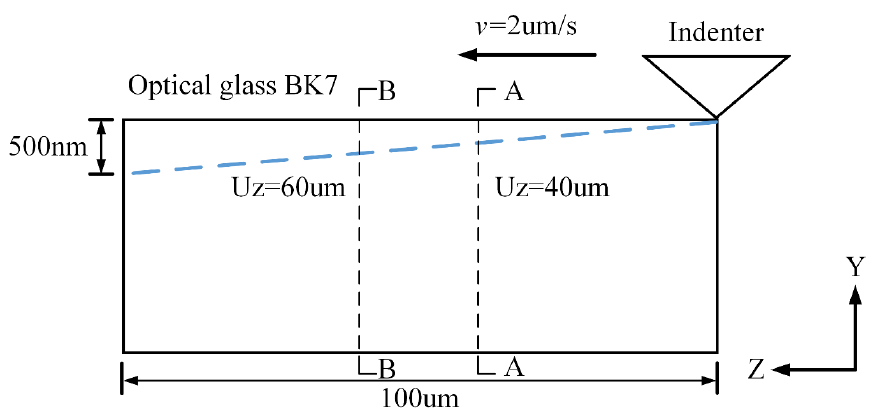
Figure 9. Illustration of a gradually increasing depth scratching in finite element method (FEM).